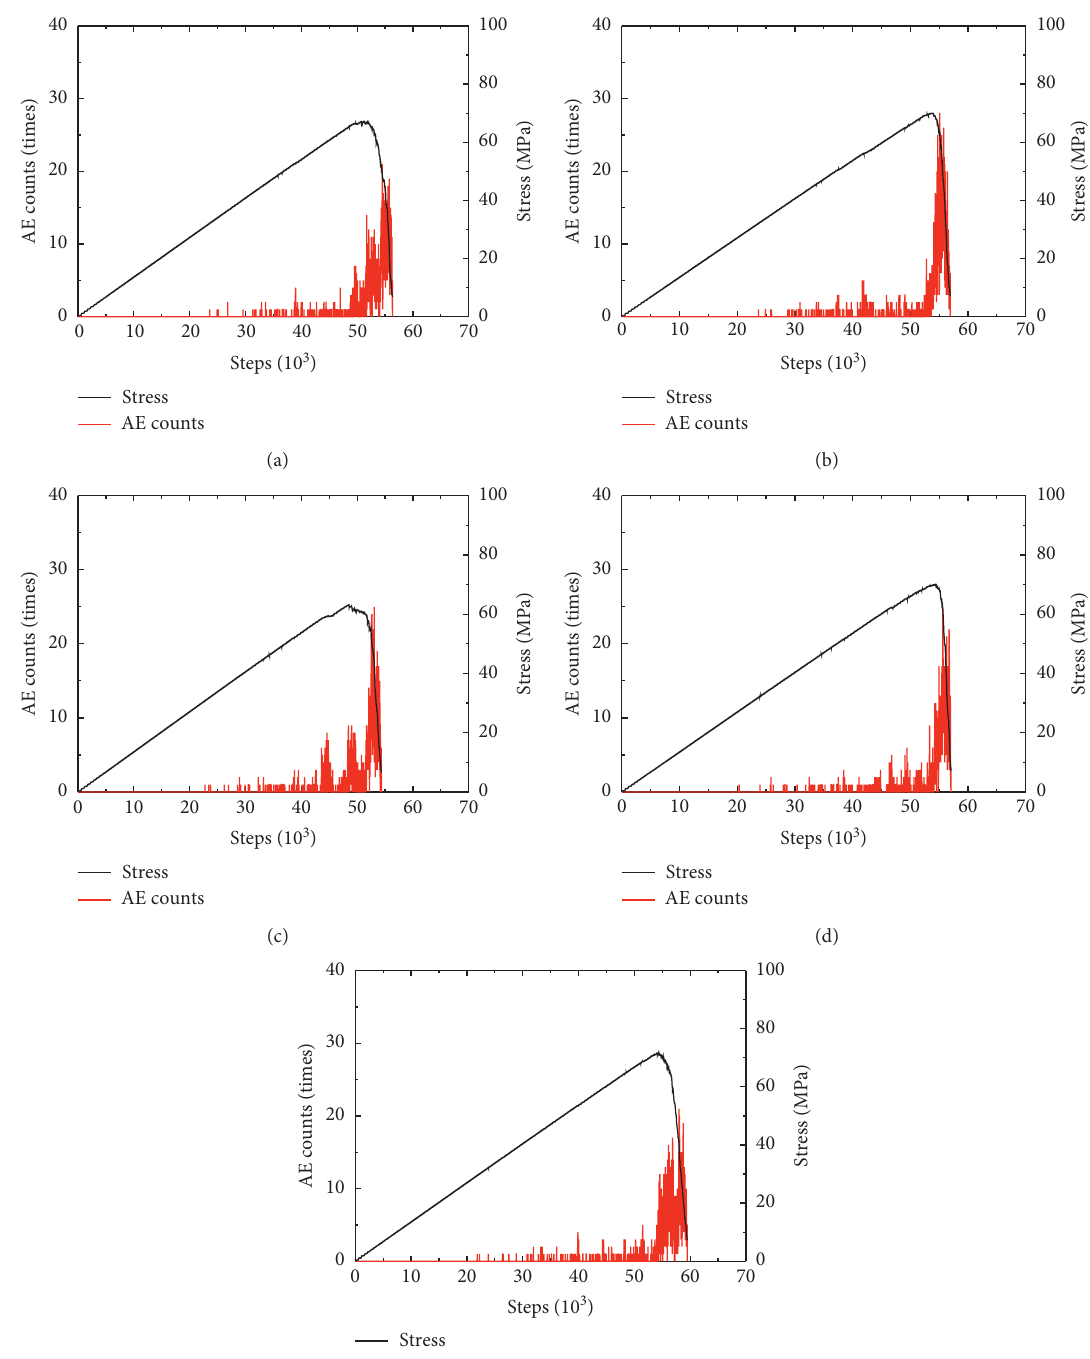
Figure 17: Stress-time-AE counts of samples with different boreholes spacing. The S of (a), (b), (c), (d), and (e) are 1 D , 2 D , 4 D , 6 D, and 8 D ,